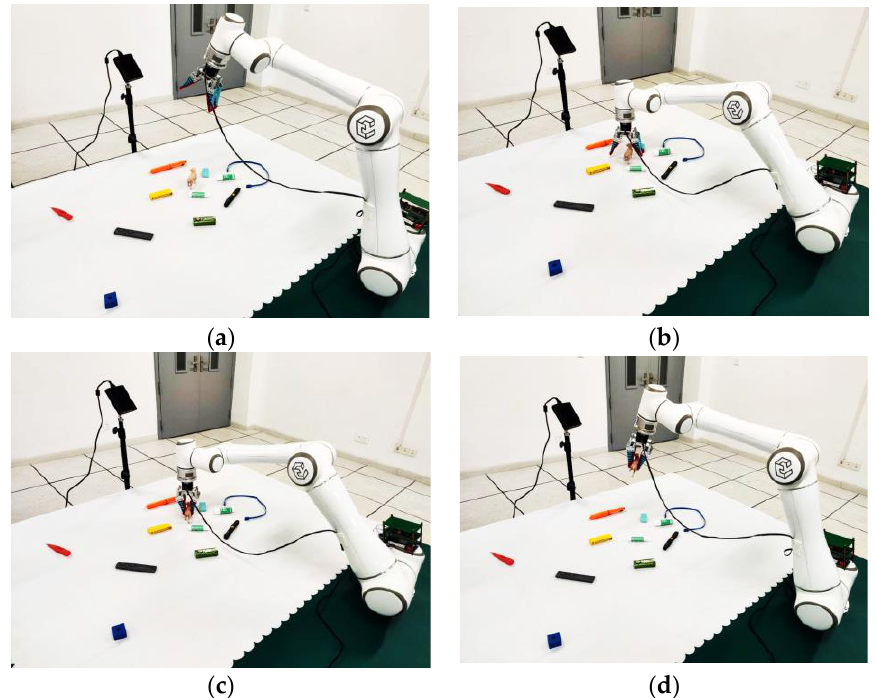
Figure 14. Four grasp stages in the physical experiment: ( a ) shows the initial position and posture of EC-66 robot. In this stage, grasp detection is performed. After detection, the parallel gripper moves to the effective grasping position, which can be seen in ( b ). The gripper then grasps the target, which is shown in ( c ). The robot completes the target grasping task in ( d ) finally.